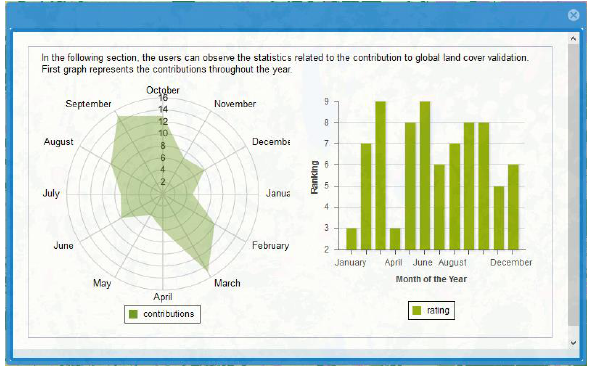
Figure 3. User statistical